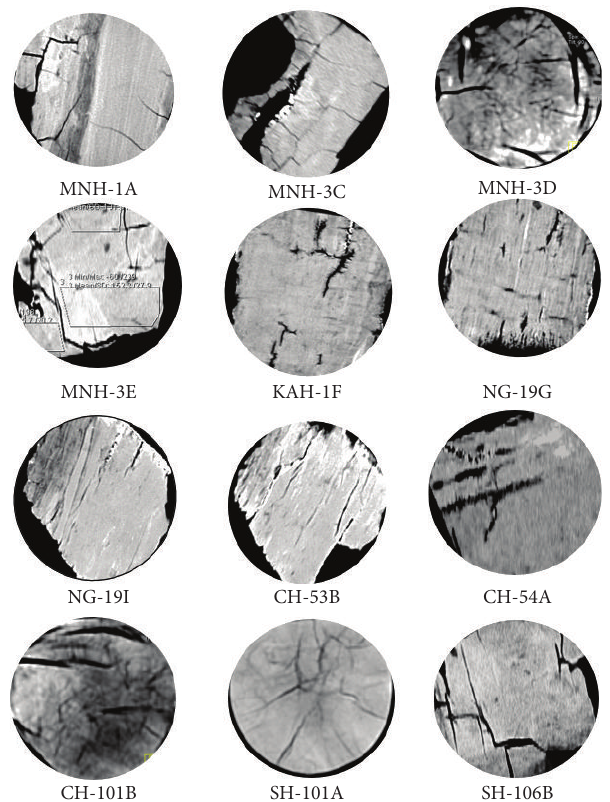
Figure 3: The result of CT scan of slice coal on 12 representative coal